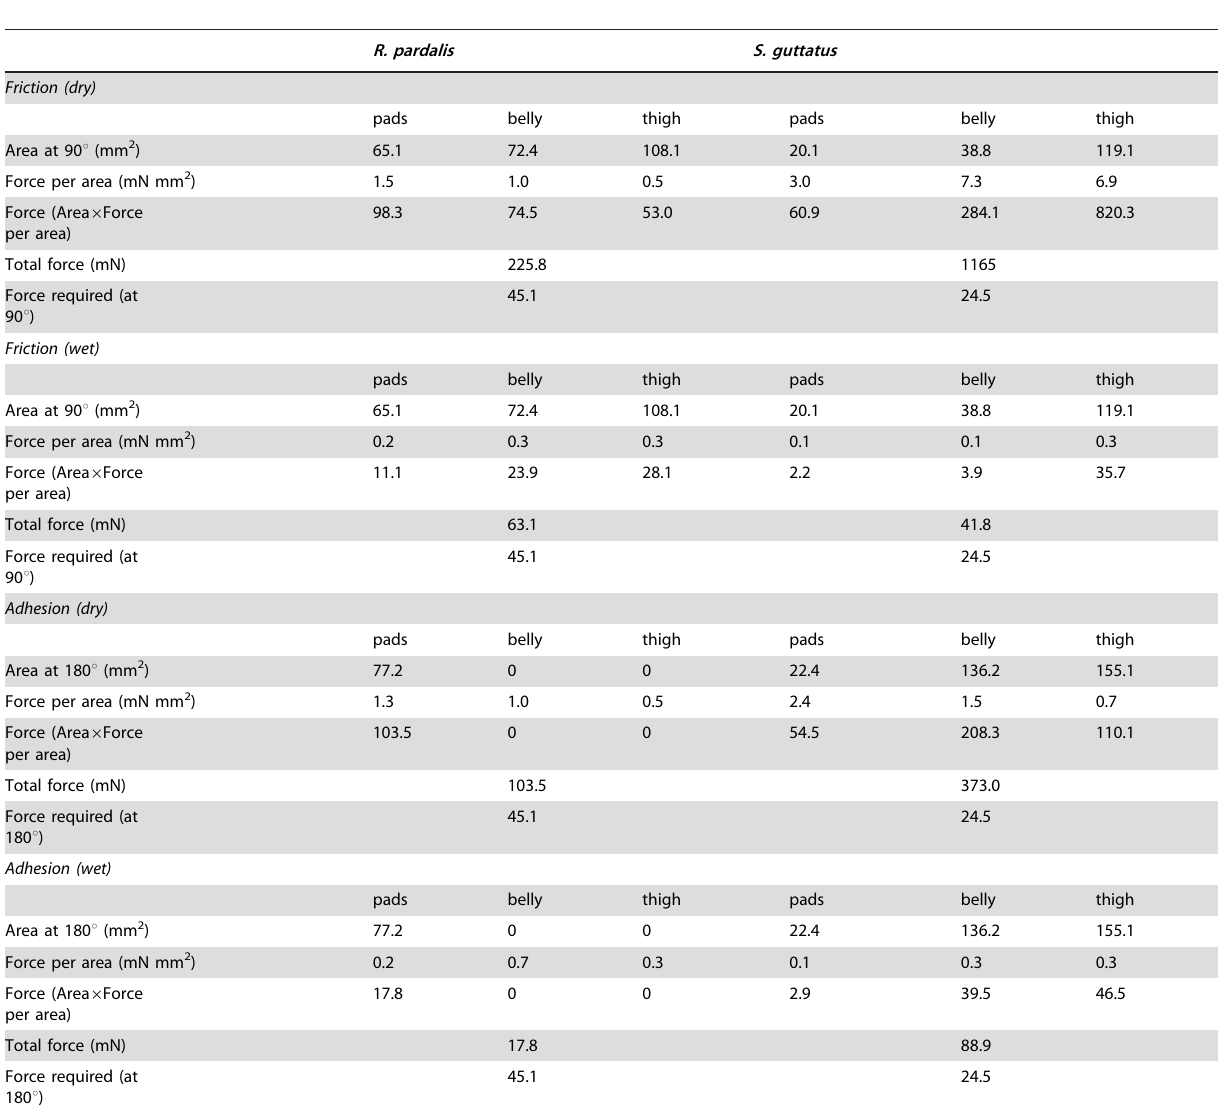
Table 2. Combining the contact area with the force per area measurements to calculate maximum attainable forces under different